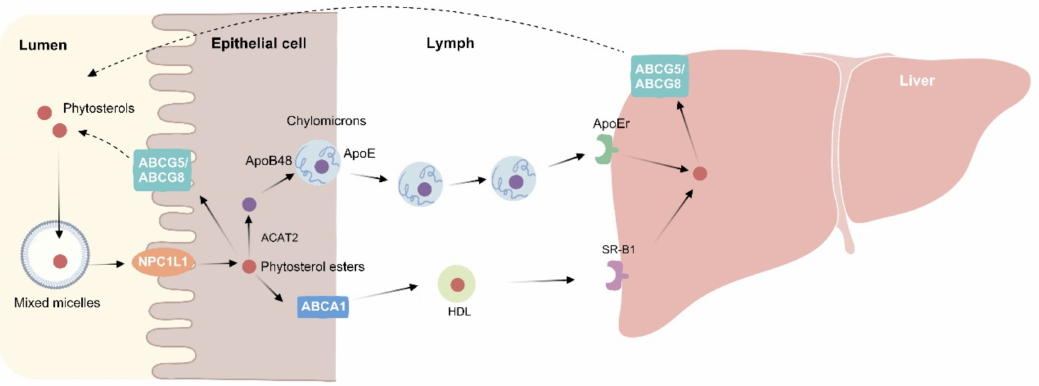
Figure 2. Phytosterol metabolism. In the intestinal lumen, dietary fat, cholesterol, and bile acids mix to form micelles. Phytosterols compete with cholesterol to enter the micelles. Free phytosterols are absorbed by intestinal epithelial cells via NPC1L1 and then esterified by acyl-CoA: cholesterol acyltransferase isoform 2 (ACAT2) to cholesteryl esters and incorporated into chylomicron. The unesterified phytosterols are secreted back into the intestinal lumen via ATP binding cassette (ABC) G5/8. After chylomicron enters the circulation, it transfers free fatty acids to the peripheral tissues, and its residues are taken up by the liver via ApoE -dependent receptor (ApoEr). Phytosterols in the liver can also be transported back into the intestinal lumen via the ABCG5/8 transporter at the hepatobiliary interface. On the other hand, phytosterols from intestinal epithelial cells can also enter HDL through ABCA1 at the basolateral membrane. HDL is recognized by the scavenger receptor class B type 1 (SR-B1) receptors in the liver and then absorbed into the